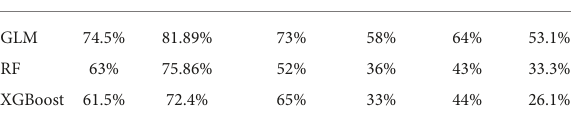
TABLE 4 Performance comparison between the three